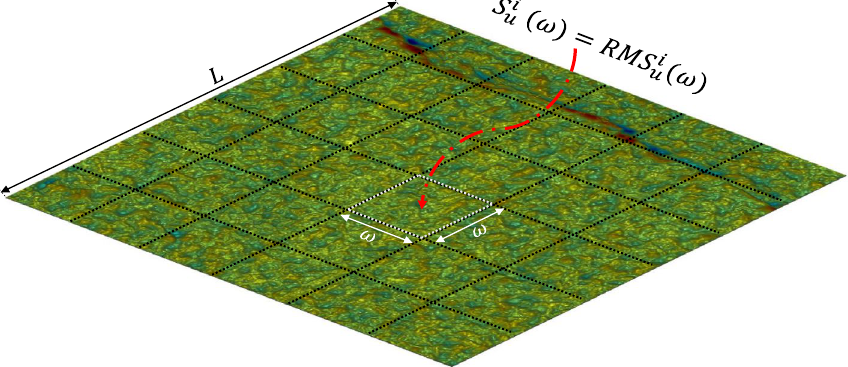
Figure 7. Window length ( ω ) selection of a separated unevenness. L and ω are the sample length and the i RMS i window length, respectively. S u (ω) and u (ω) are the standard deviation and the root mean square of the height of unevenness in a window,